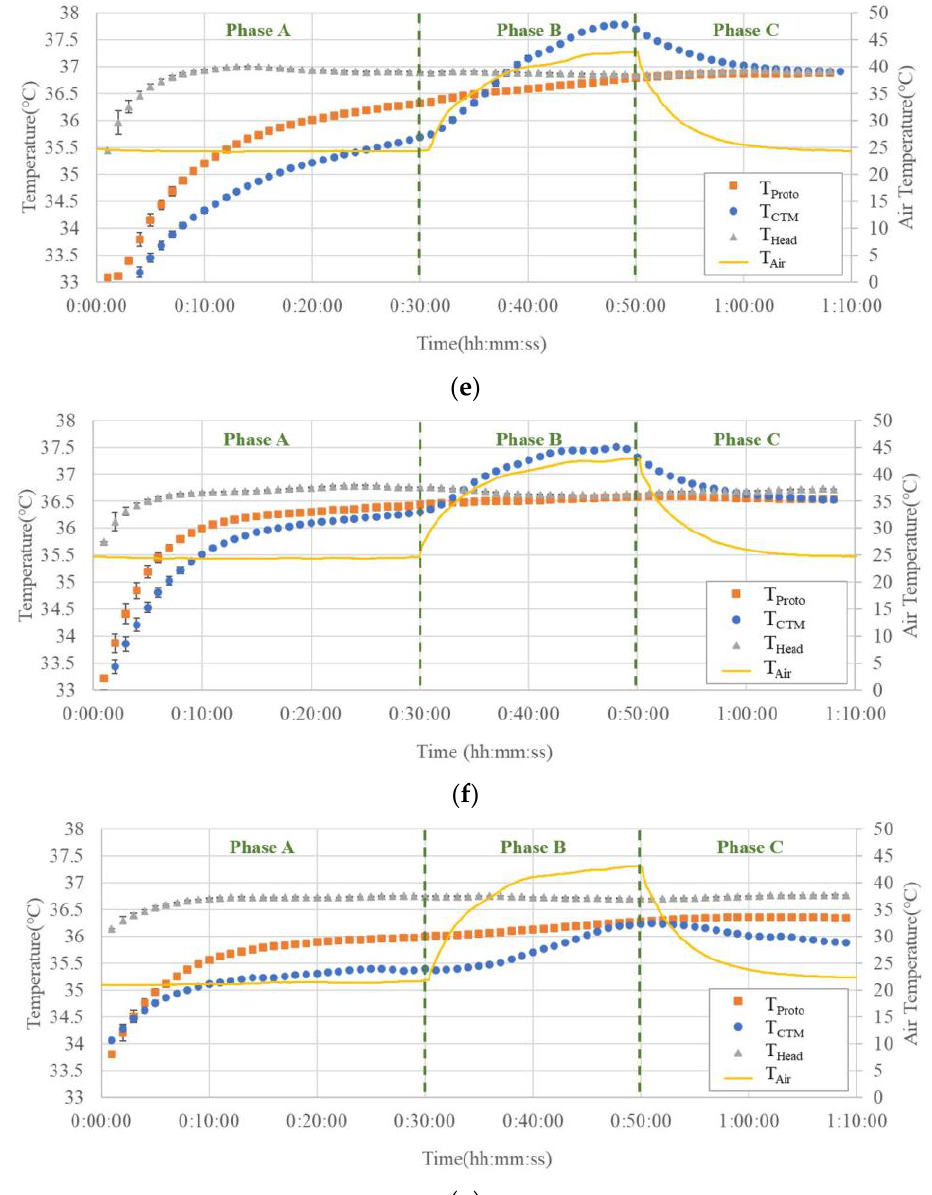
Figure 9. ( a – g ) Measurement results of the sauna experiments for seven subjects. T Proto and T CTM represent the abdominal deep temperatures measured by the prototype probe and CTM, respectively, and T Head represents the forehead deep temperature measured by CTM before (Phase A), during (Phase B), and after (Phase C) hot air blowing.